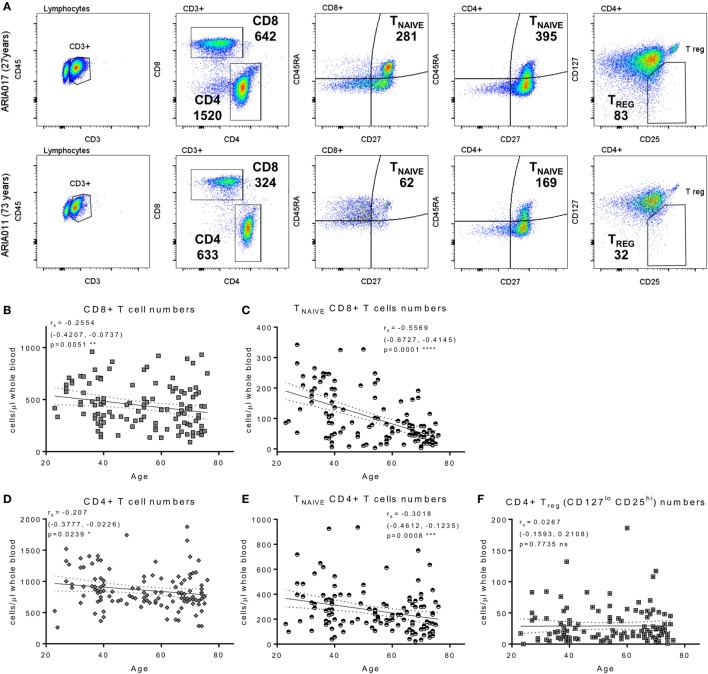
Impact of aging on T cell numbers. EDTA treated whole blood was stained with a panel of phenotyping antibodies in order to enumerate CD4+ and CD8+ T cells and their subsets. Representative dot plots from a young and old donor showing CD4+ and CD8+ T cell gates, naïve T cells subset were defined by CD27+ and CD45RA+ (TNAIVE) expression, and CD4+ T regulatory cells (Treg—CD25hi, CD127lo); the number of cells per microliter of whole blood present for each gated population of interest are also indicated (A). Graphs illustrating the numbers of total CD8+ T cells (B), TNAIVE CD8+ T cells (C), total CD4+ T cells (D), TNAIVE CD4+ T cells (E), and CD4+ Treg cells (F) of the entire ARIA cohort (n = 119) correlated to donor age. The relationship of T cell subset numbers with donor age was analyzed using Spearman rank correlation with the results indicated on each graph [rs (95% confidence interval) and p value]. There was a significant decrease in total and TNAIVE CD4+ and CD8+ T cells with age, CD4+ Treg numbers showed no significant difference.